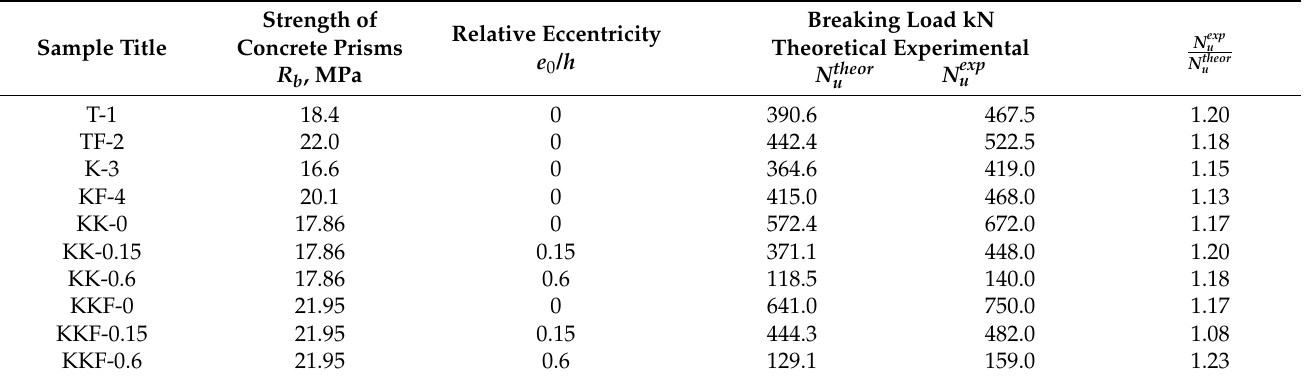
Table 8. Bearing capacity of short BFRC